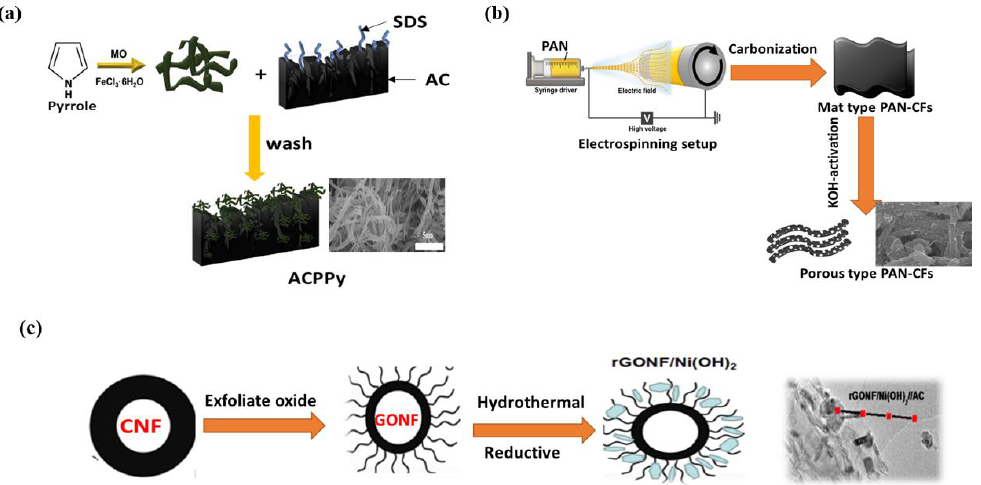
Figure 2. ( a ) Schematic layout of synthesis of activated carbon/polypyrrole (AC-PPy)